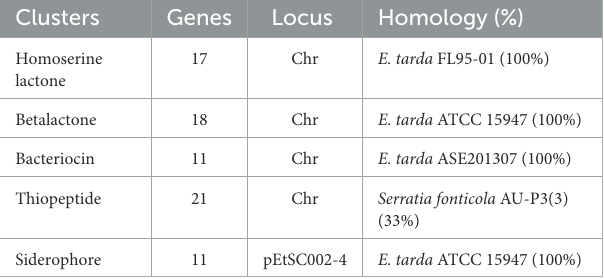
TABLE 3 Effector/secretory protein profiling encoded by the